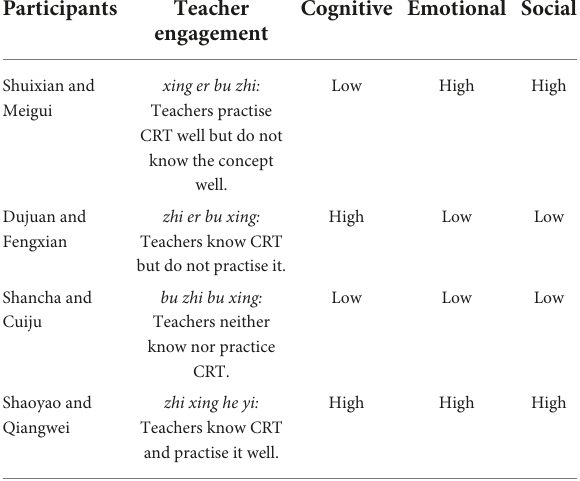
TABLE 2 A summary of main